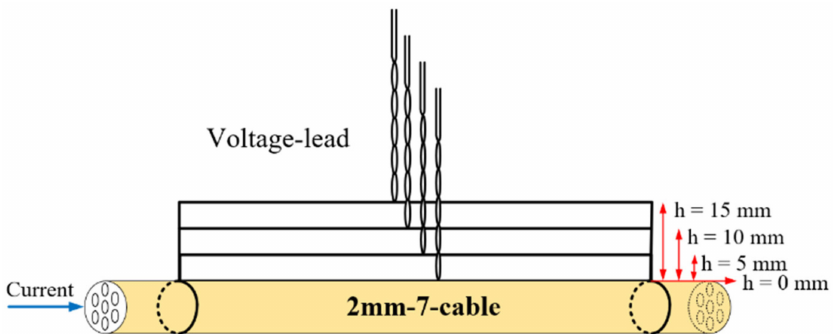
Figure 6. Schematic diagram of voltage-lead height of 2 mm-7-cable.